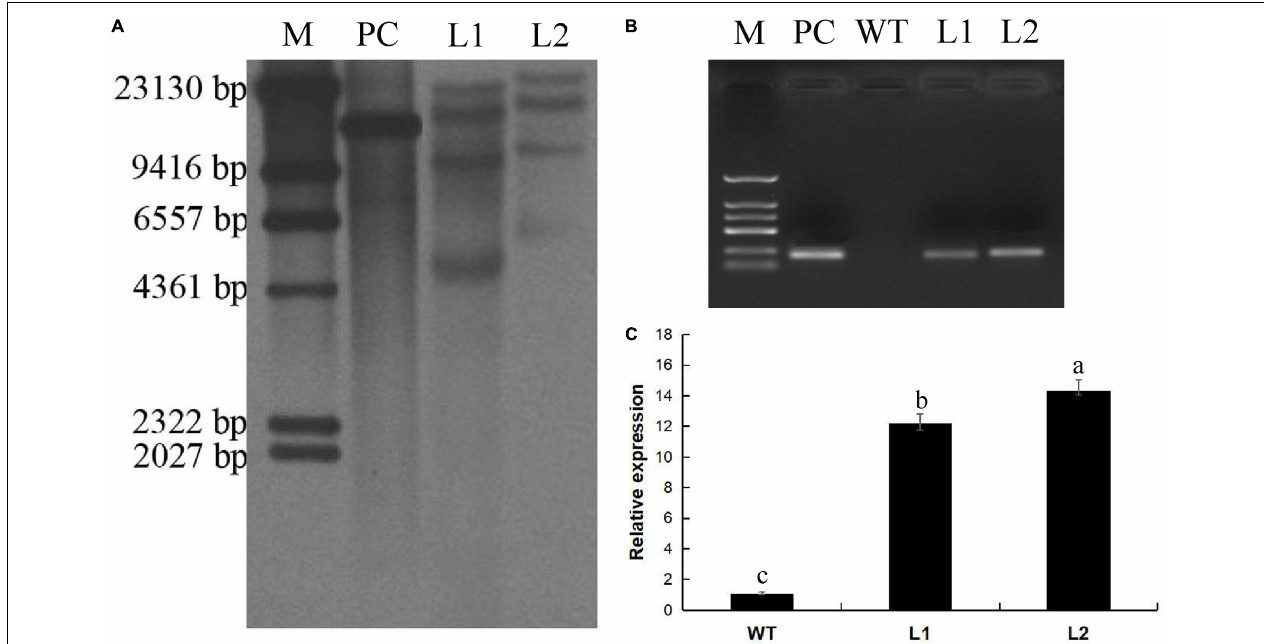
FIGURE 2 | Characterization of the transgenic lines. (A) Integration of MaPIP1;1 transgene in Line 1 (L1) and Line 2 (L2) by Southern blot (35S promoter in the pcambia 1302 vector). (B) PCR amplification of the GFP gene in transgenic lines. (C) qRT-PCR analysis of the expression of MaPIP1;1 in transgenic lines. Data are means ± SD of n = 3 biological replicates. Means denoted by the same letter do not significantly differ at P < 0.05 as determined by Duncan’s multiple-range test. M, marker; PC, positive control.